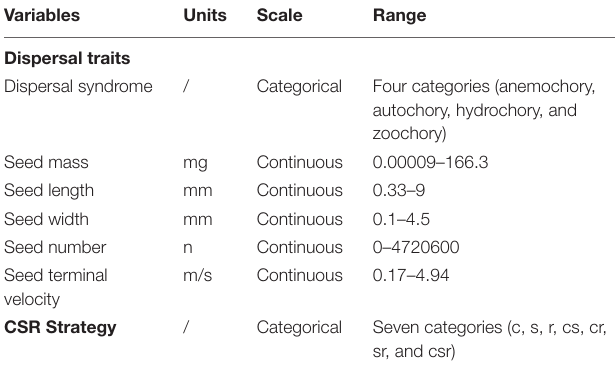
TABLE 1 | Predictor variables (dispersal traits, CRS strategy) used in the conditional inference tree to predict occurrence of populations of endangered plant species across the different types of